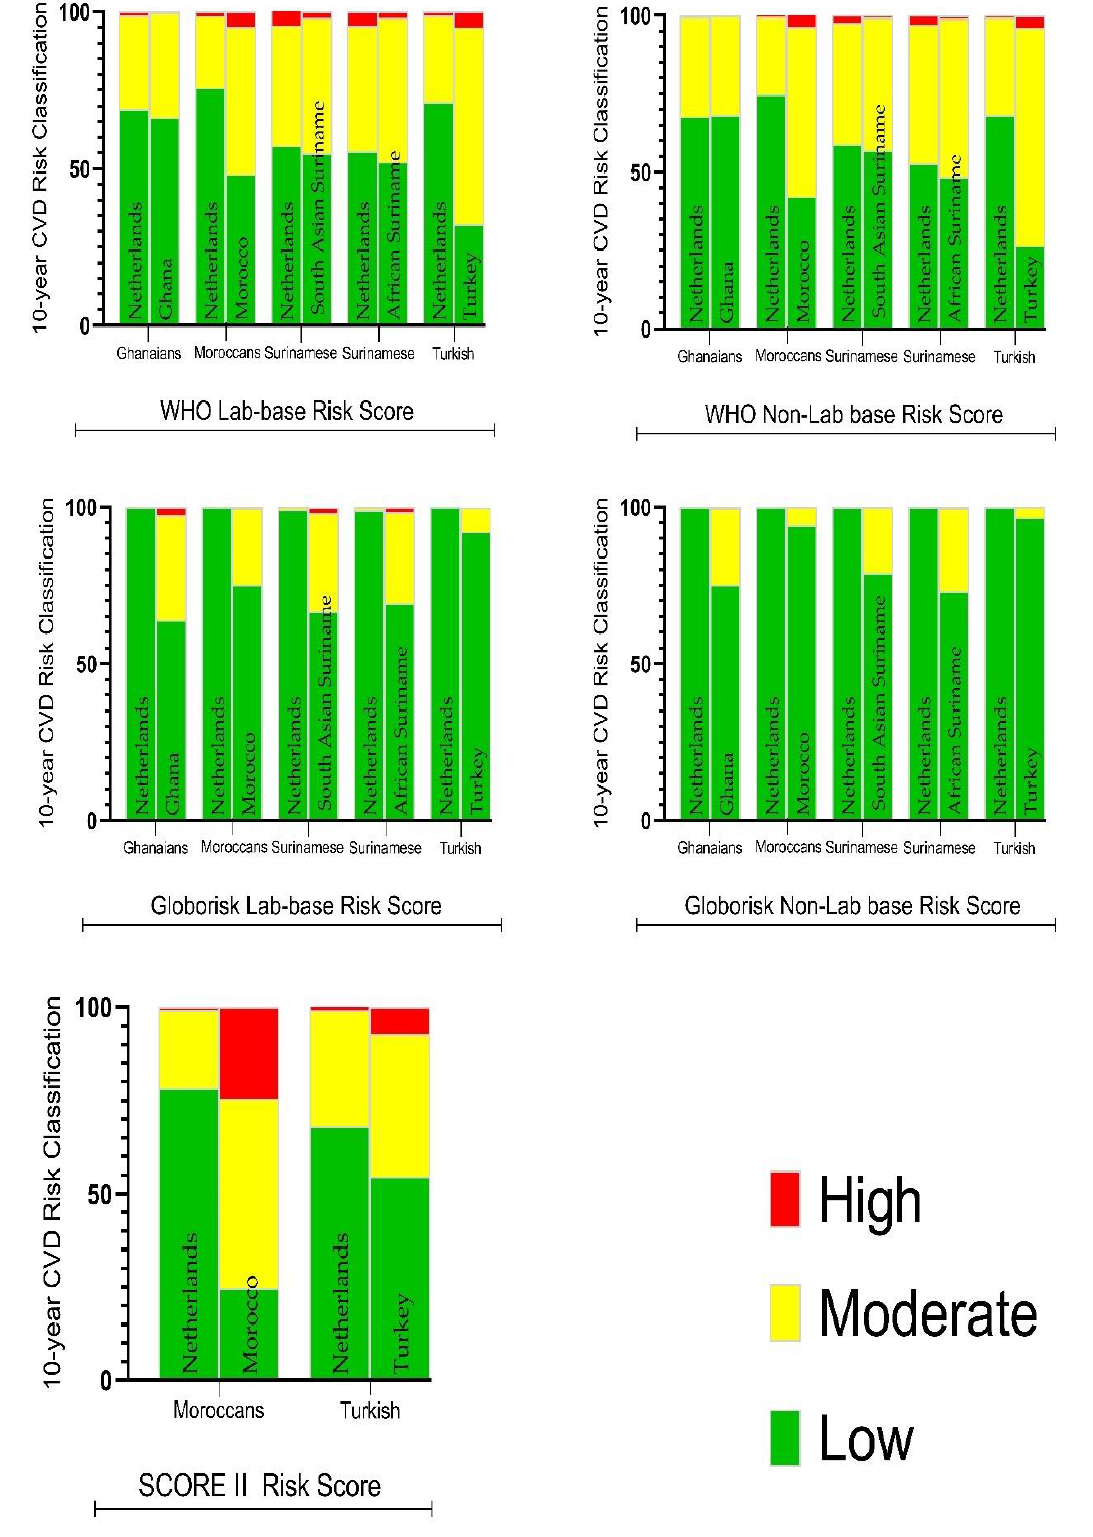
Figure 1. Percentage CVD Risk Classification among a multiethnic population living in the Netherlands, using the Netherlands/Dutch versus country-of-birth cardiovascular-risk scores. High = High risk CVD, Moderate = Moderate risk CVD, Low risk of CVD .